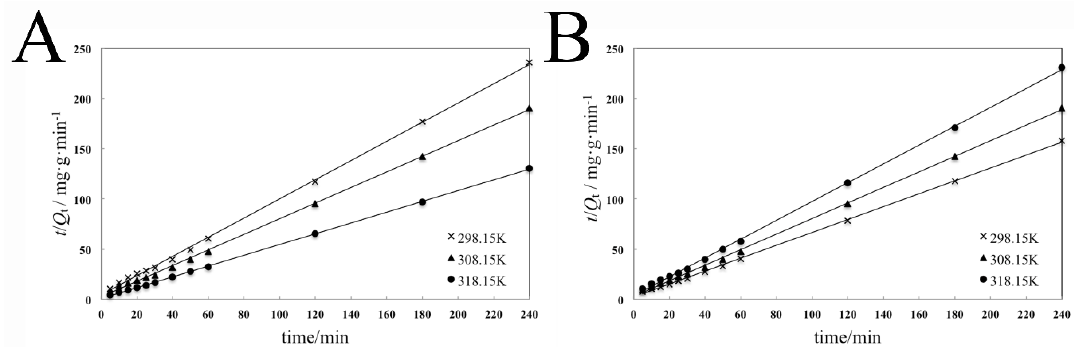
Figure 9. Pseudo-second-order adsorption isotherms of the adsorption process of dispersant 2700 on pyraclostrobin crystal II ( A ) and pyraclostrobin crystal IV ( B ) at different temperatures.